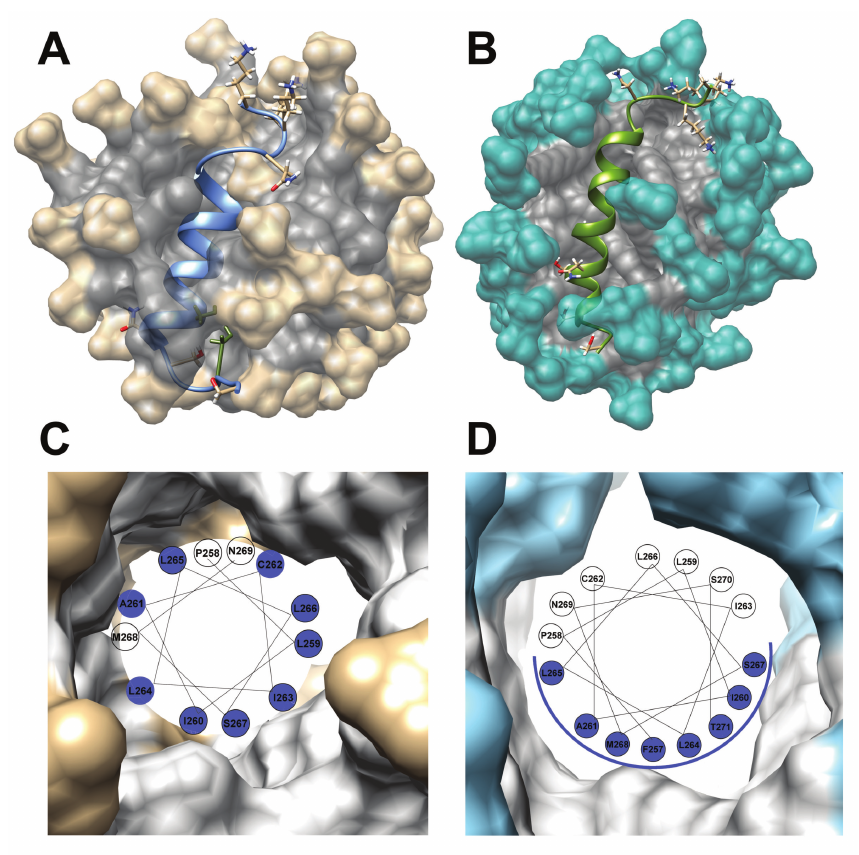
Figure 7. The 3D structure of TM4 fragment in SDS- d 25 ( A ) and DPC- d 38 ( B ) presented with hydrophobic (dark) and hydrophilic core of micelle. Visualization of the radial distribution function (RDF) data by a wheel plot of the TM4 α -helix inside SDS- d 25 ( C ) and DPC- d 38 ( D ) micelle, respectively. The residues with side chains located in the hydrophobic environment are highlighted in